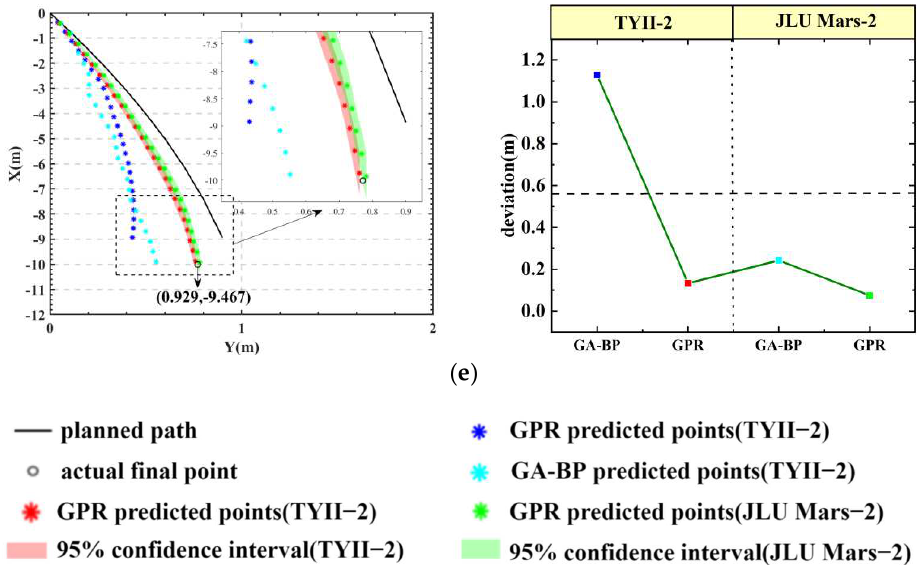
Figure 12. Planning path, predicted path, and deviation from sol.27–sol.36: ( a ) sol.27; ( b ) sol.28; ( c ) sol.34; ( d ) sol.36; ( e ) sol.40.